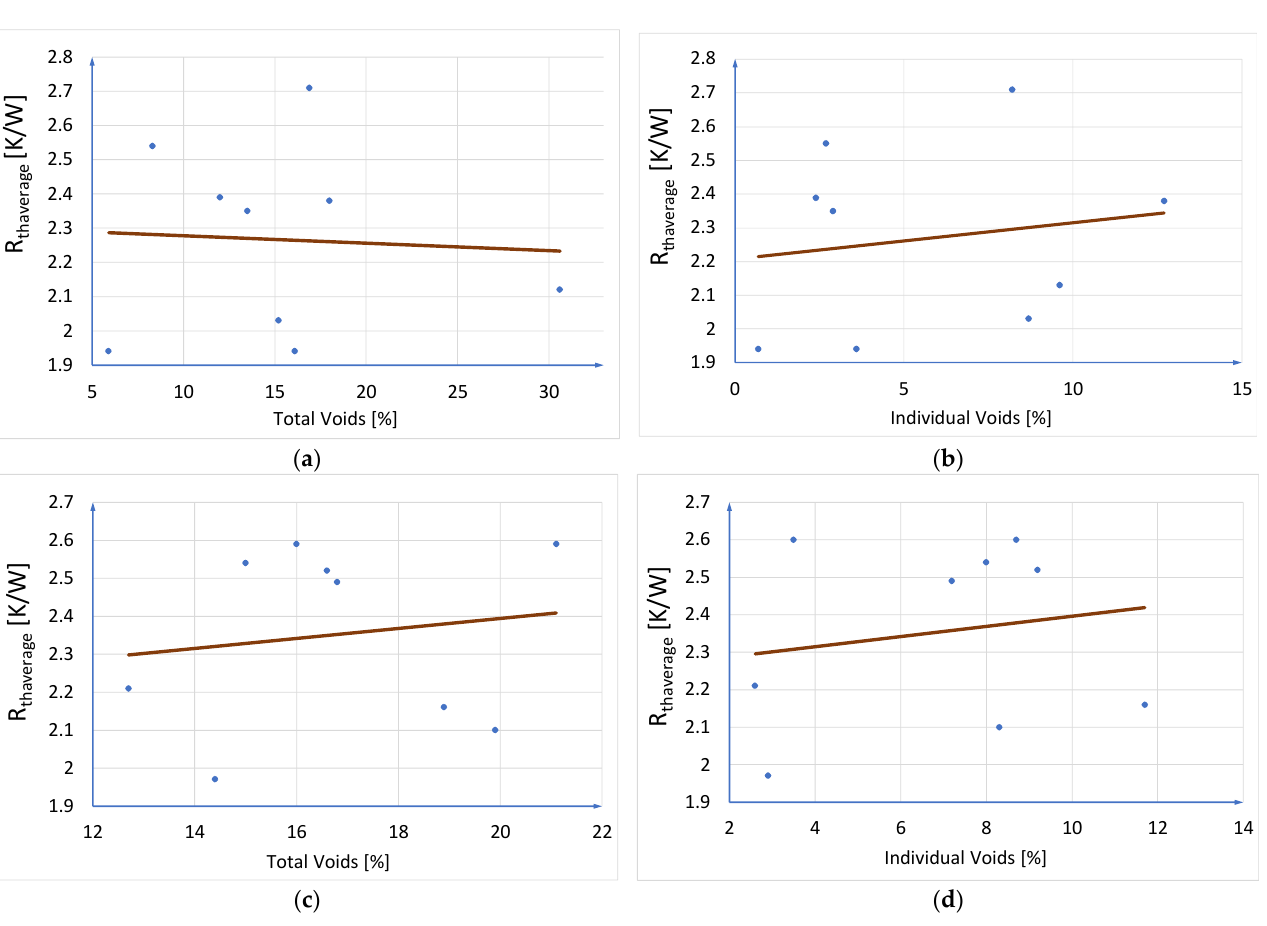
Figure 5. Regression analysis illustrating the effect of void spaces on the R th value together with the p -value: ( a ) for TR_A (Total Void), ( b ) for TR_A (Individual Void), ( c ) for TR_B (Total Voids), ( d ) for TR_B (Individual Voids).